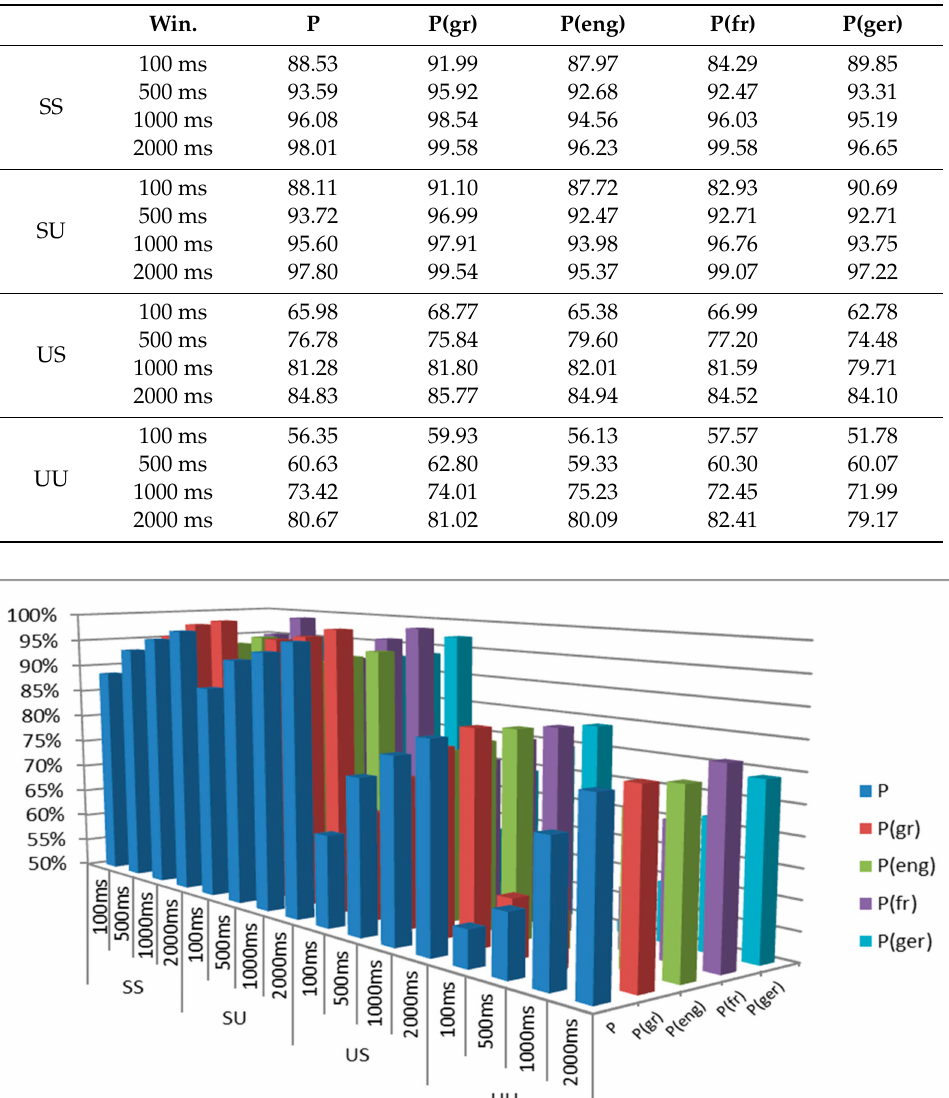
Table 6. Classification Results for LD Scheme.